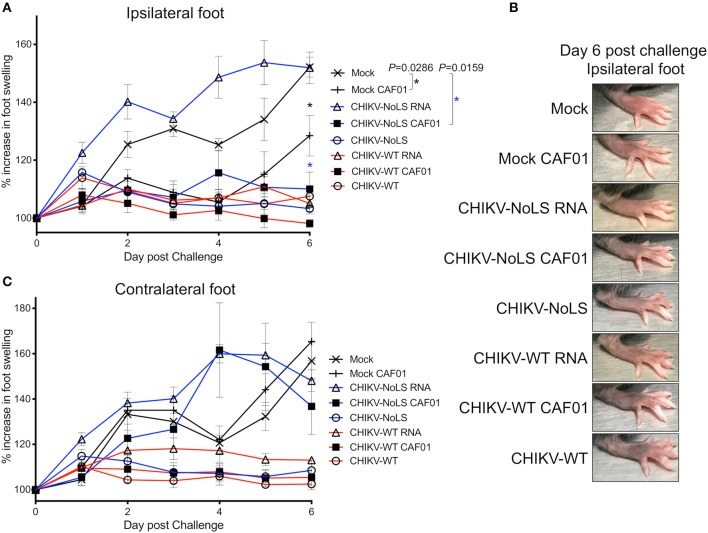
CHIKV-NoLS CAF01 inoculation protects against CHIKV disease in the ipsilateral foot of C57BL/6 mice upon CHIKV-WT challenge. C57BL/6 mice were inoculated with viable virus particles (104 pfu CHIKV-WT or CHIKV-NoLS), CAF01 delivered RNA (2 μg CHIKV-WT or CHIKV-NoLS RNA complexed with 0.3 mg CAF01) or RNA alone (2 μg CHIKV-WT or CHIKV-NoLS RNA) subcutaneously in the ventral/lateral side of the right foot. Mock inoculated mice received 20 μl VP-SFM media or VP-SFM media containing 0.3 mg CAF01. At 30 days post inoculation, mice were challenged with 104 pfu CHIKV-WT in the ventral/lateral side of the (A,B) ipsilateral or (C) contralateral foot and monitored daily for footpad swelling. Each symbol represents the mean ± standard error from five to six mice. Statistical analysis was performed by non-parametric Mann–Whitney t-test between the groups indicated on the figure legend by the bar and *color, and P-value.